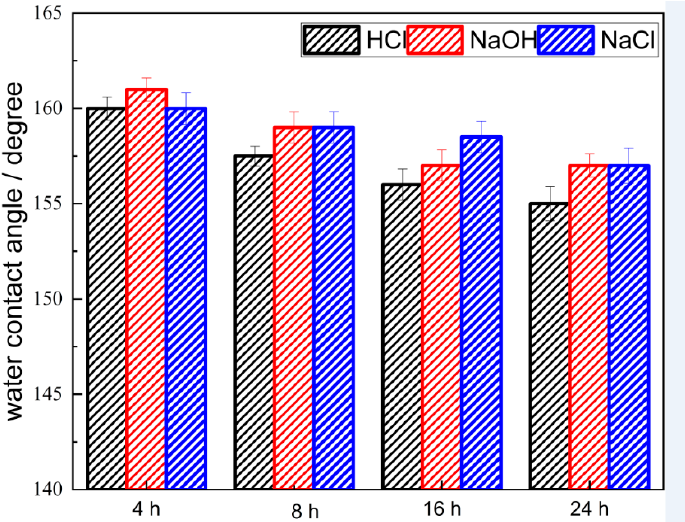
Figure 9. WCA test of DP8–1.5 layered membrane immersed in acid–base salt solution.